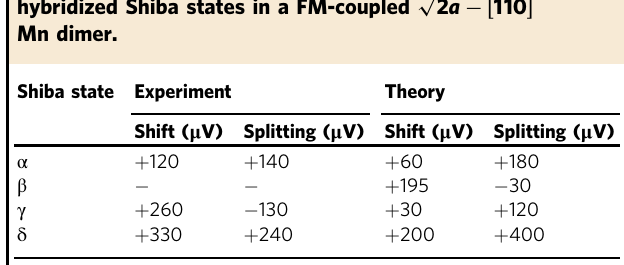
Table 1 Comparison of energetic shifts and splittings of hybridized Shiba states in a